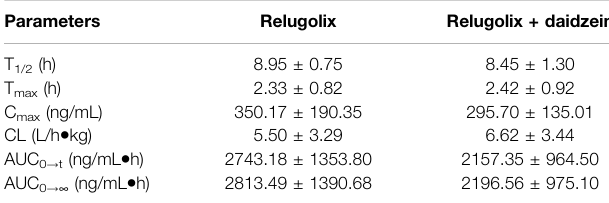
TABLE 3 | Main pharmacokinetic parameters after taking a single oral dose of relugolix with or without daidzein to rats ( n = 6). Parameters T 1/2 (h)